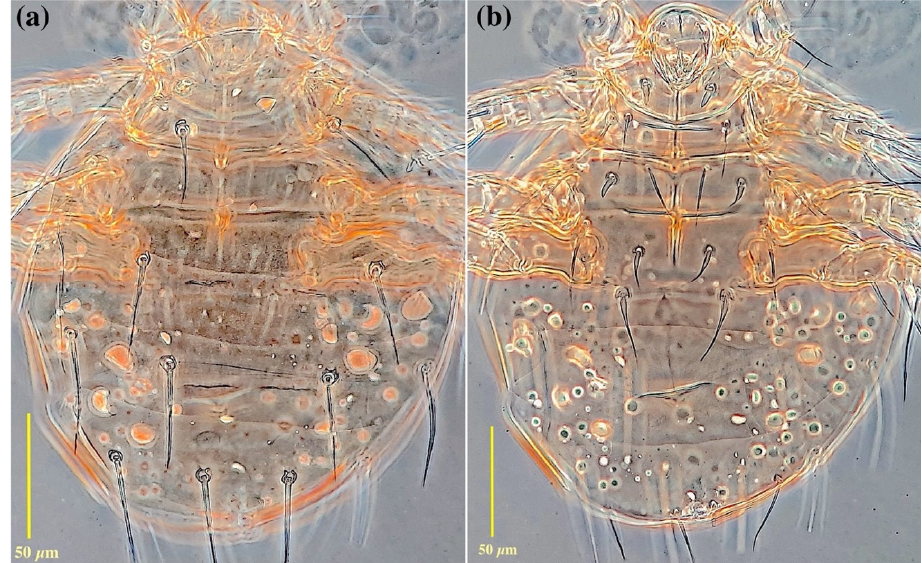
Figure 8. Micrograph of Archidispus hydrophilus sp. nov., phoretic female ( a ) dorsal general view; ( b ) ventral general view .